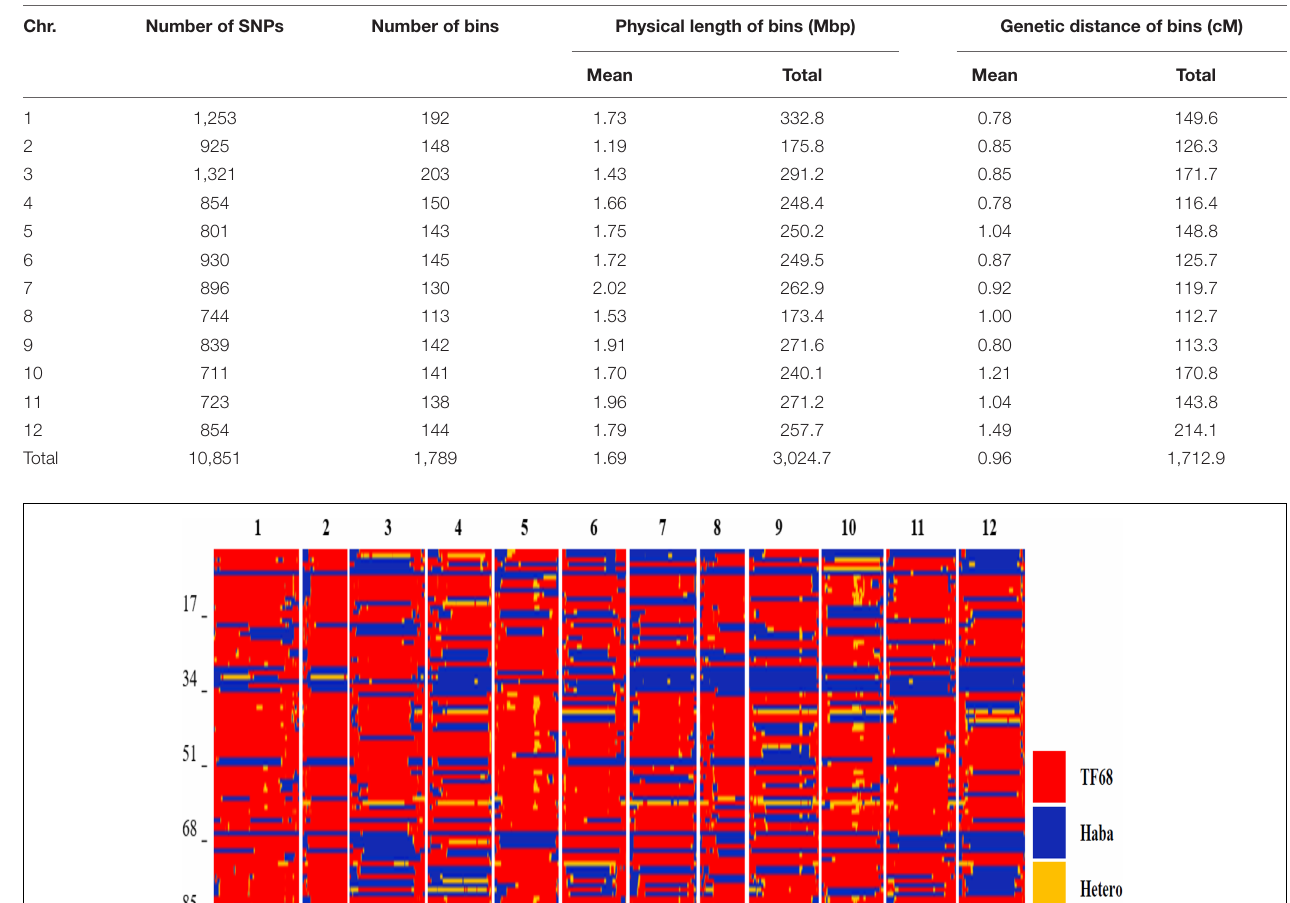
TABLE 2 | Summary of bins on each chromosome of the TH RIL population by GBS. Chr.